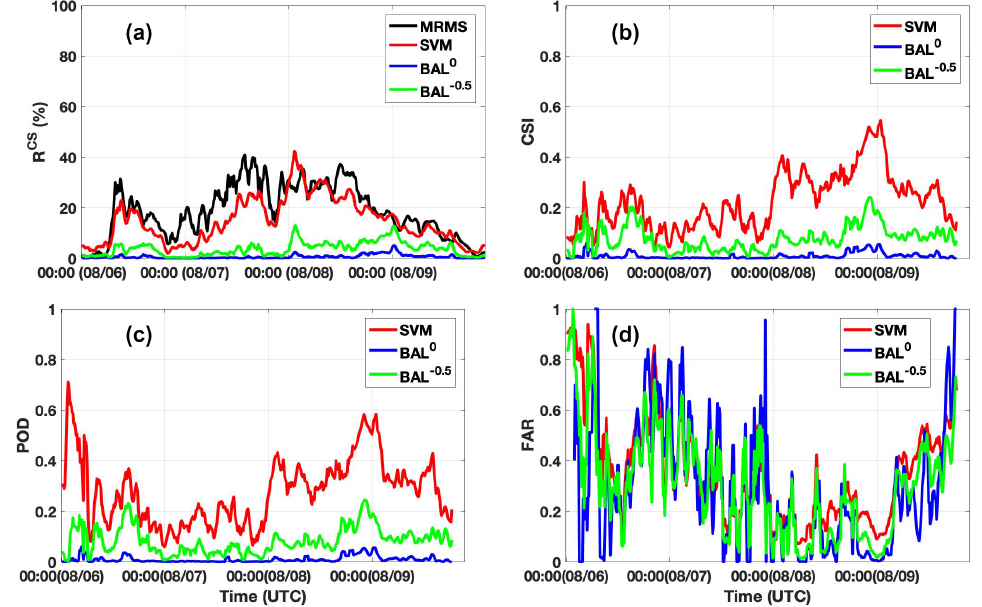
Figure 8. The time series plot of R CS (a) , CSI (b) , POD (c) , and FAR (d) from 6–9 August 2009; 96h data are used in each case. The results from BAL with the threshold T 0 = − 0 . 5, BAL with the threshold T 0 = 0, SVM, and MRMS are indicated by green, blue, red, and black lines, respectively.